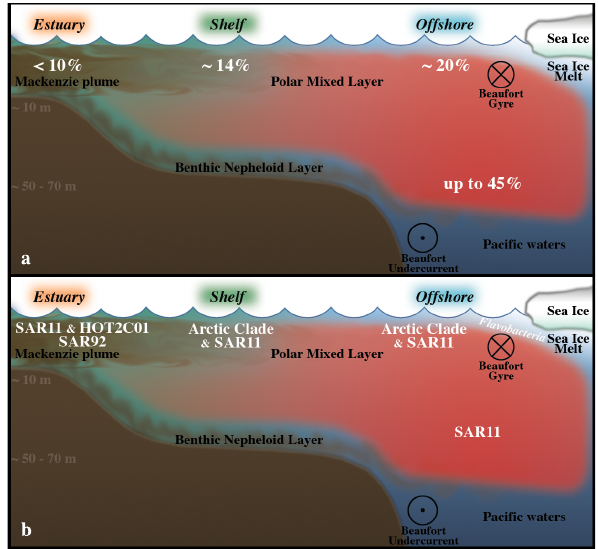
Figure 6. Schematic diagram representing the changes in abun- dance (a) and diversity (b) of major PR bacterial clades along an onshore–offshore transect of the Beaufort Sea. Total PR abundance (a) was calculated by summing the relative proportions of the eight most abundant clades in the clone libraries (Fig.